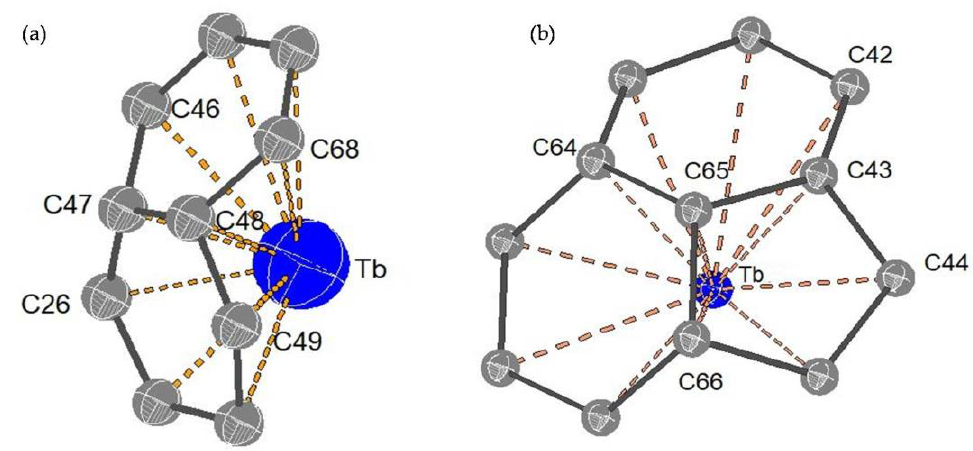
Figure 5. The interaction of the metal cation (major metal site) with the nearest cage carbon atoms for ( a ) Tb@C 2v (9)-C 82 and ( b ) Tb@C S (6)-C 82 . ( a ) Tb@C 2v (9)-C 82 and ( b ) Tb@C S (6)-C 82 .